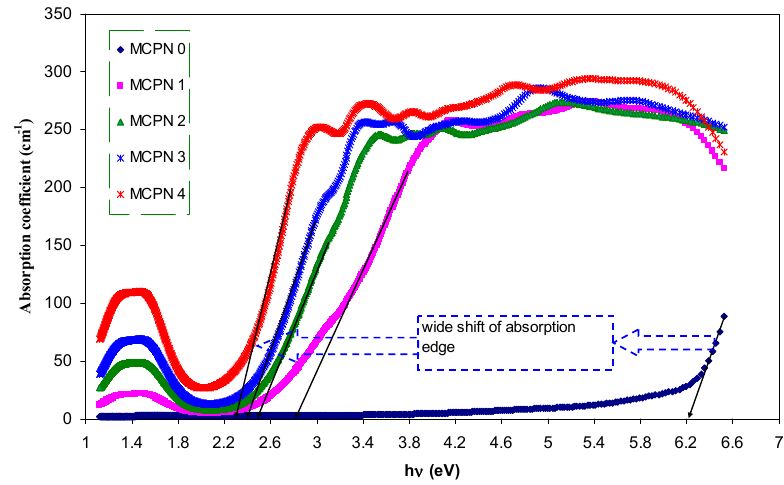
The absorption spectra of pure MC and MC nano-composite samples. Polymers 2017 , 9 , 194